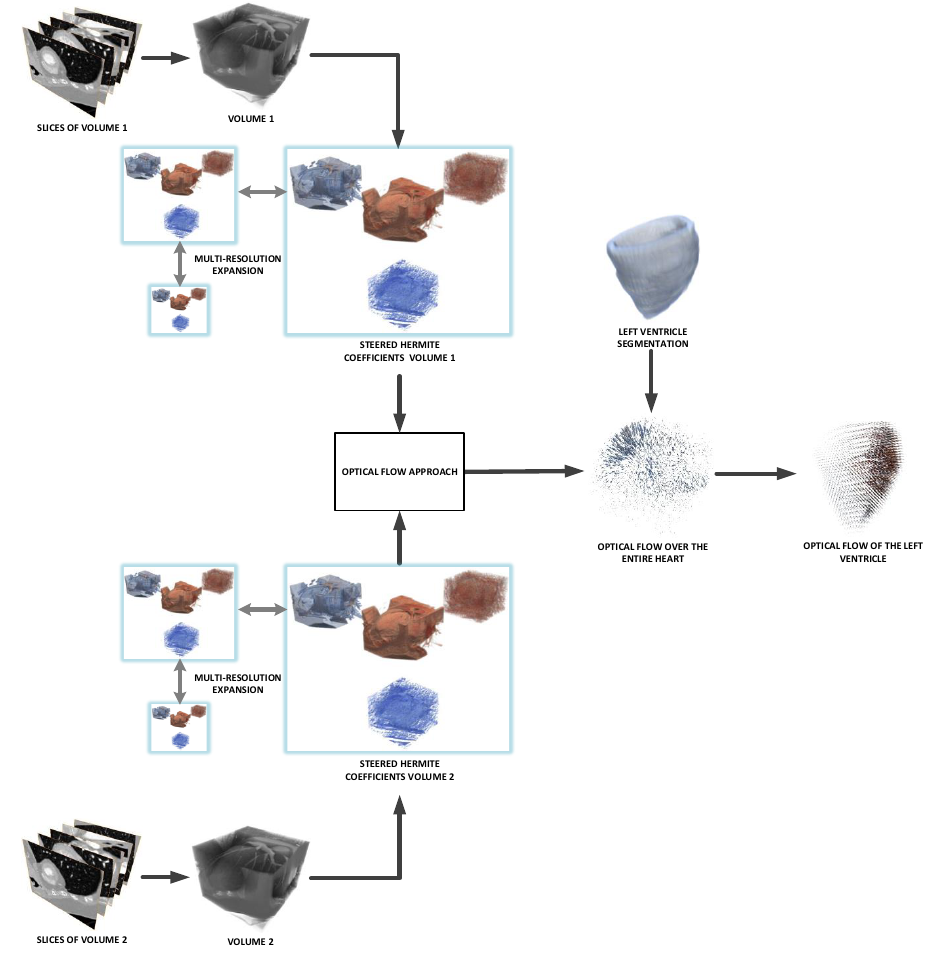
Figure 7. Procedure to implement the HOF3D